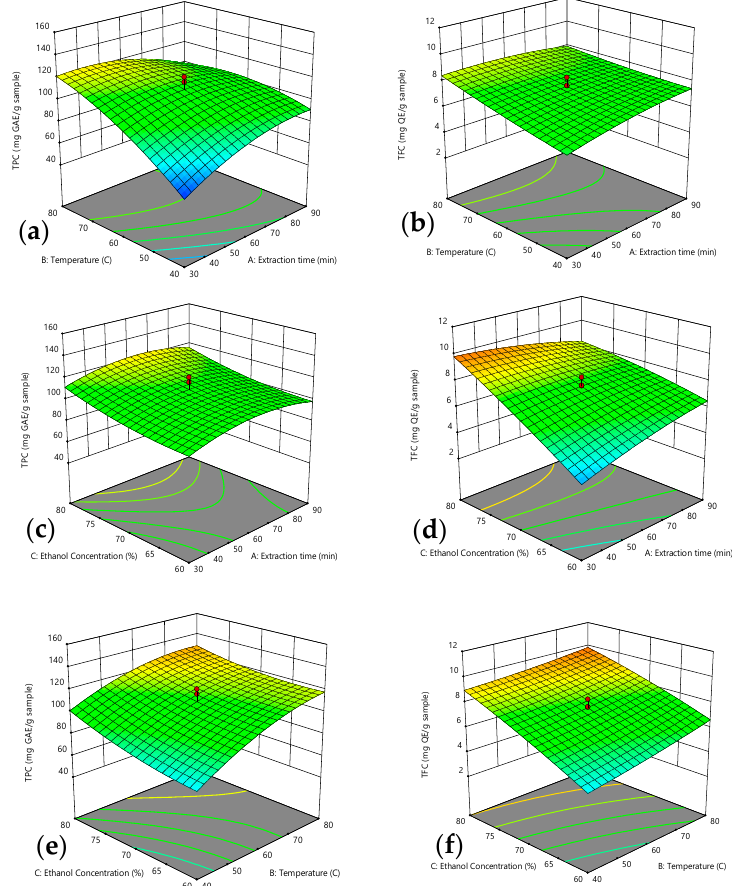
Figure 1. Response surface for: ( a , b ) effect of extraction time and temperature; ( c , d ) effect of extraction time and ethanol concentration, and ( e , f ) effect of temperature and ethanol concentration, on total phenolic content (TPC) (a,c,e) and TFC (b,d,f).